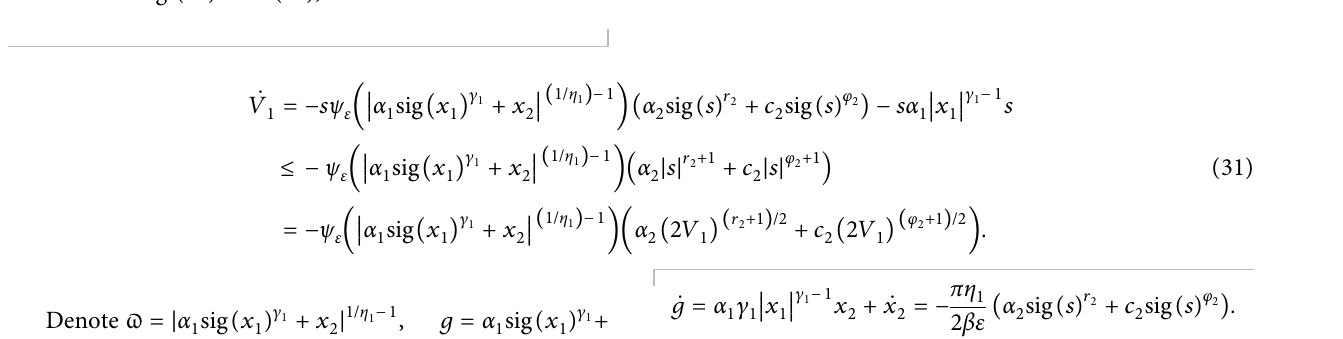
Figure 1: Comparison of the three sliding